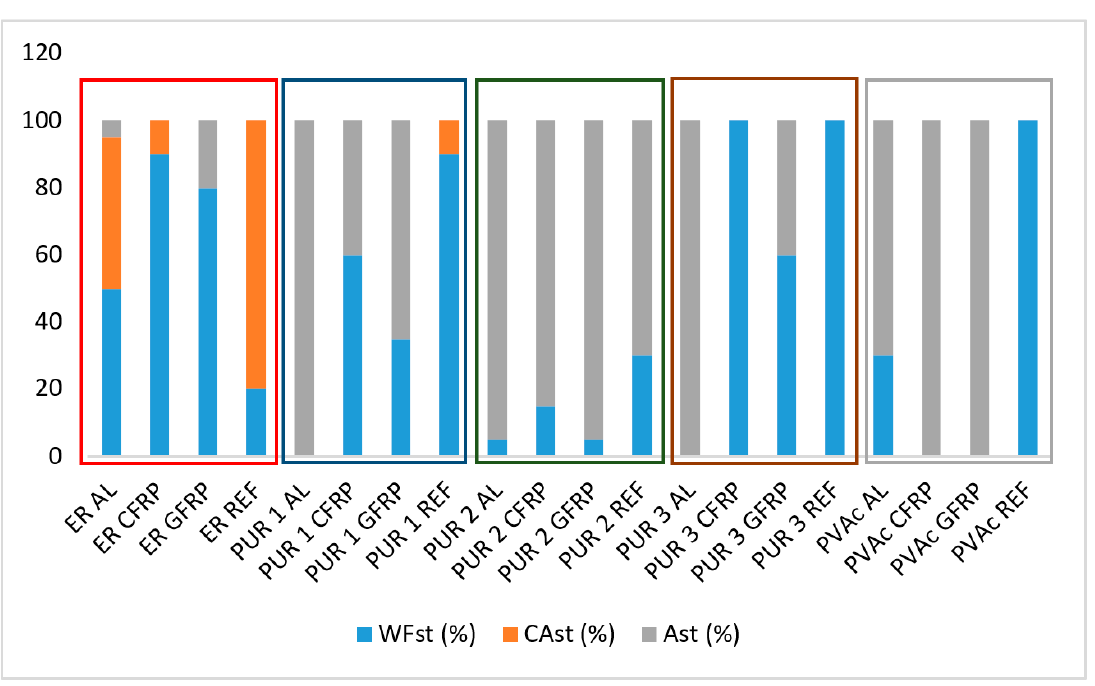
Figure 8. Failure proportions of standard climatised samples (WF—wood failure (cohesive), CA— cohesive failure in glue line, A—adhesion failure).